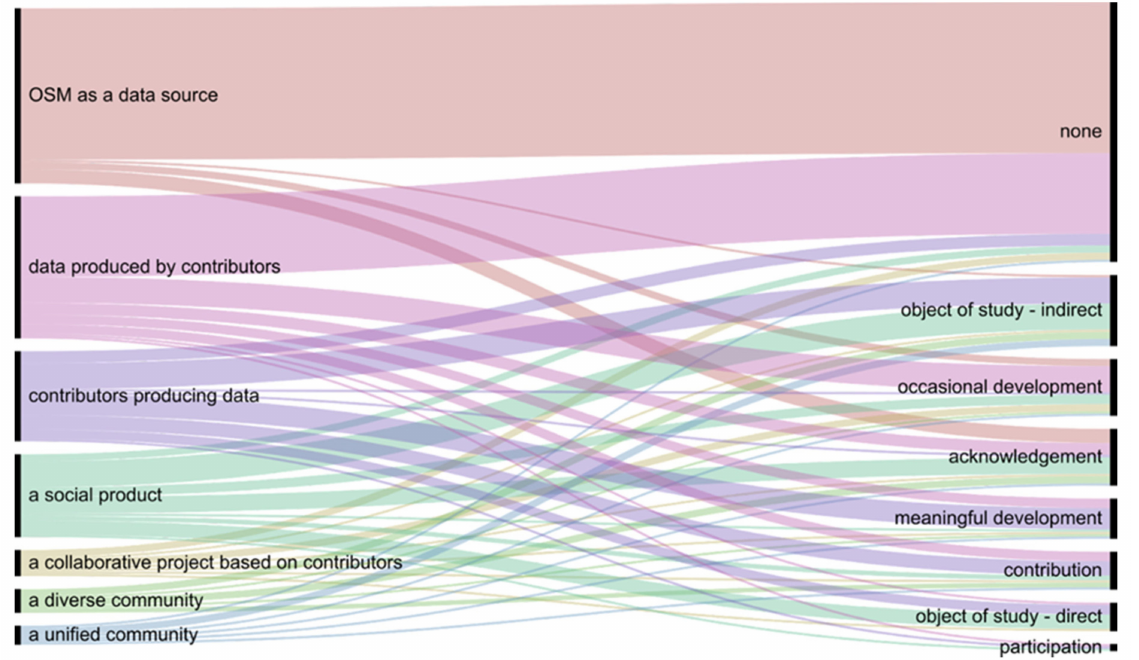
Figure 4. Alluvial diagram connecting authors’ perspective on OSM-C ( left ) with OSM-C engagement ( right